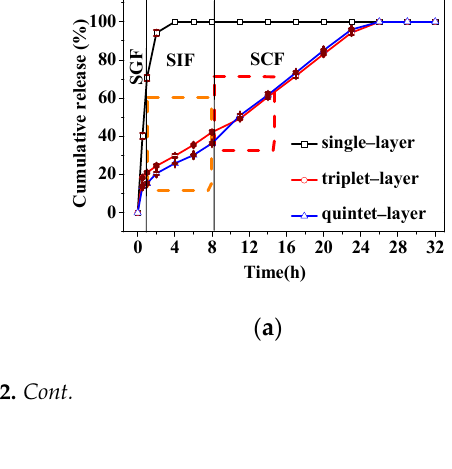
( c ) Figure 2. The release profile of protein from nanocapsules in the whole GIT ( a ), the SIF ( b ), and the SCF ( c ). Abbreviations: SGF, simulated gastric fluid; SIF, simulated intestinal fluid; and SCF, simulated colonic fluid. 3.3. Release Kinetics of Nanocapsules in Simulated GIT The release rate of nanocapsules was determined by a zero-order model with a high R 2 > 0.965 (Table 1). The K 0 value is generally related to the release rate, with a higher value indicating a faster release rate [26]. The single-layer nanocapsules showed the most rapid release rate with the maximum K 0 value of 34.267 in the SGF. As the number of layers increased to triplet, the K 0 values decreased significantly to 4.007 in the SGF and 2.935 in the SIF, suggesting that the release rate was much slower than that of the single- layer nanocapsule in the upper GIT. With further increase to quintet-layer, there were smaller K 0 values compared to the triplet-layer in the SGF and SIF; however, K 0 values increased slightly and were more than those of the triplet-layer , in the SCF. To sum up, the quintet-layer nanocapsule showed the best controlled-release properties for IN in the GIT. Table 1. Regression equation of drug-release kinetics of protein in the GIT. Nanocapsule GIT